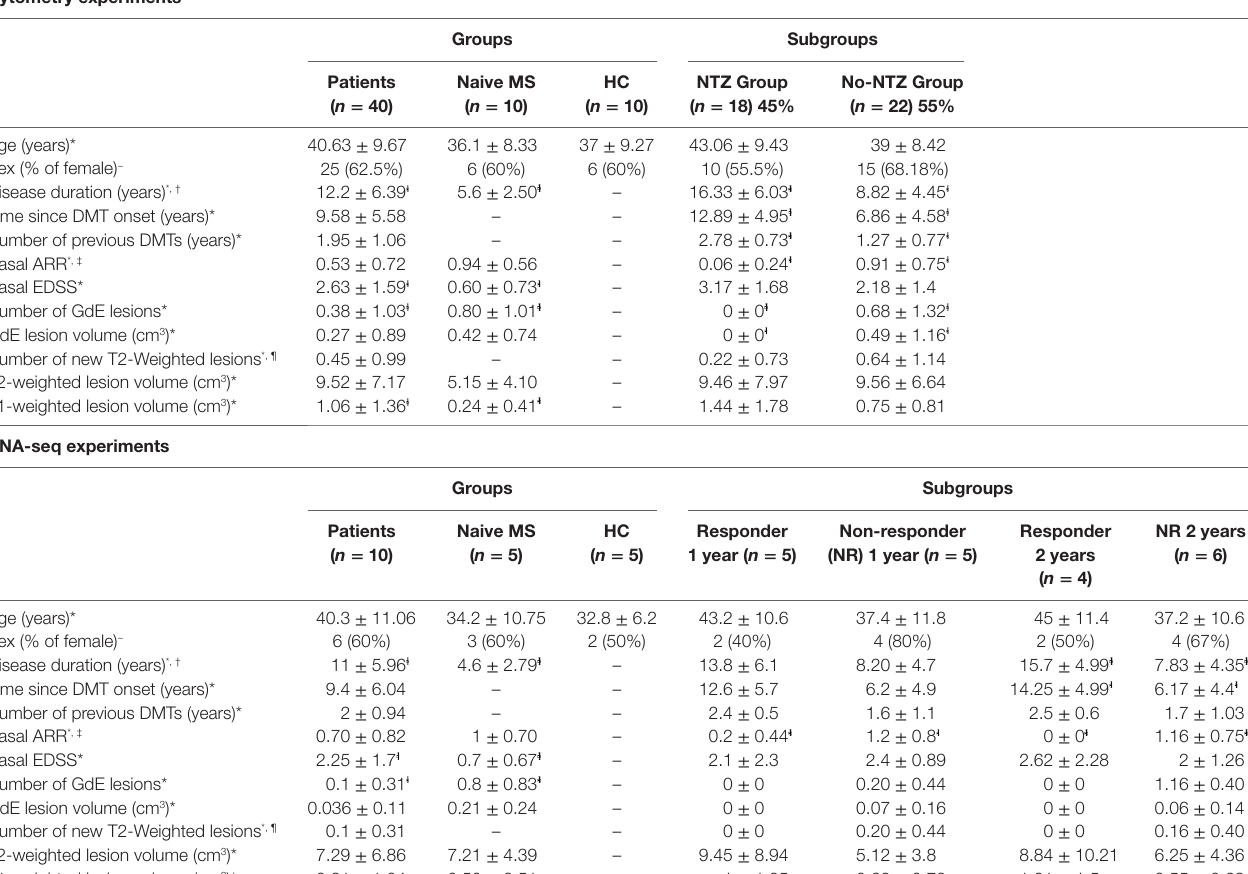
TaBle 1 | Demographic characteristics of patients and control